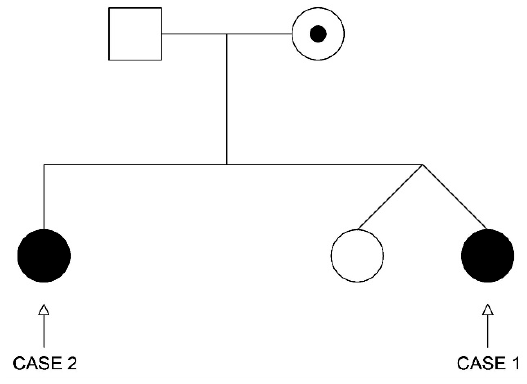
Figure 2. Genealogical tree of the family.